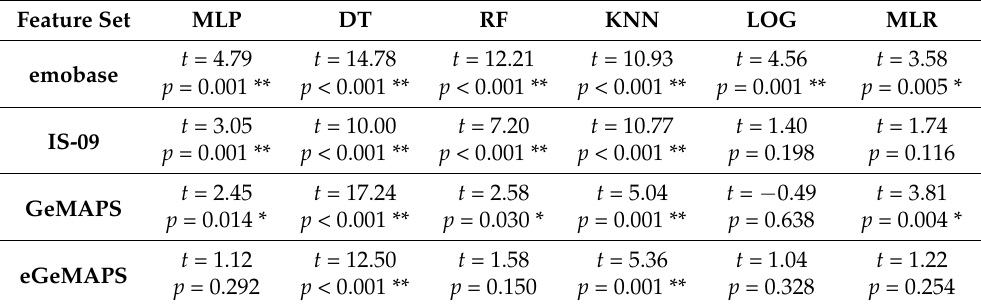
Table 4. Cross-Validated Paired T-Test Comparison (two-tailed) with the Test Base SMO Classifier. *: p < 0.05. **: p ≤ 0.001. Note that positive t-values indicate better performance of the SMO classifier. Classifier and feature set names and abbreviations are written